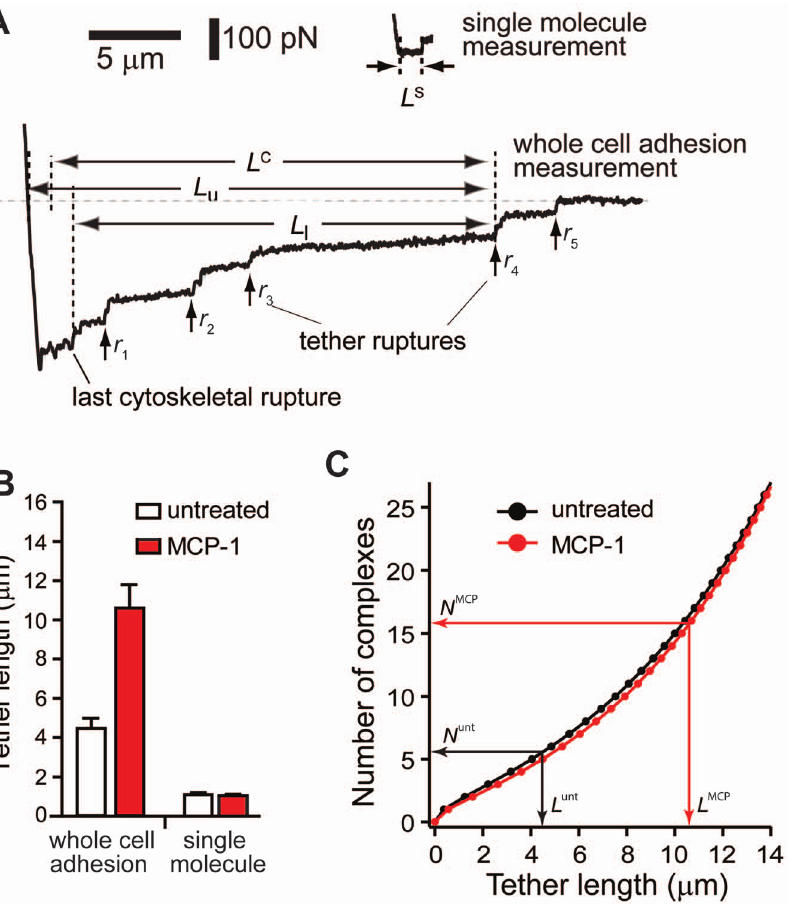
Figure 5. Individual tethers in whole cell measurements were supported by multiple a 4 b 1 /VCAM-1 complexes. (A) Comparison of AFM force measurements acquired with extensive (whole cell measurement) and minimal (single molecule measurement) cell-substrate contact. L S is the length of tethers supported by a single a 4 b 1 /VCAM-1 complex as detected in single molecule measurements. In whole cell adhesion measurement shown, the cell detachment process involved the formation and breakage of at least 5 membrane tethers, labeled r 1 through r 5 . Each tether is suppoted by multiple a 4 b 1 /VCAM-1 complexes. The lower and upper limits ( L l and L u ), and the average length ( L C ) of fourth tether ( r 4 ) are shown. (B) Comparison of average tether lengths from whole cell measurements ( L C ) and tether lengths from single molecule measurements ( L S ). (C) Estimates of the number of a 4 b 1 /VCAM-1 complexes in a tether generated during the whole cell measurements. Black and red plots provide the range for the number of a 4 b 1 /VCAM-1 complexes in a single tether for untreated and MCP-1 stimulated cells, respectively. The superscripts unt and MCP associated with N (number of complexes) and L (tether length) designate untreated and MCP-1-stimulated cells,